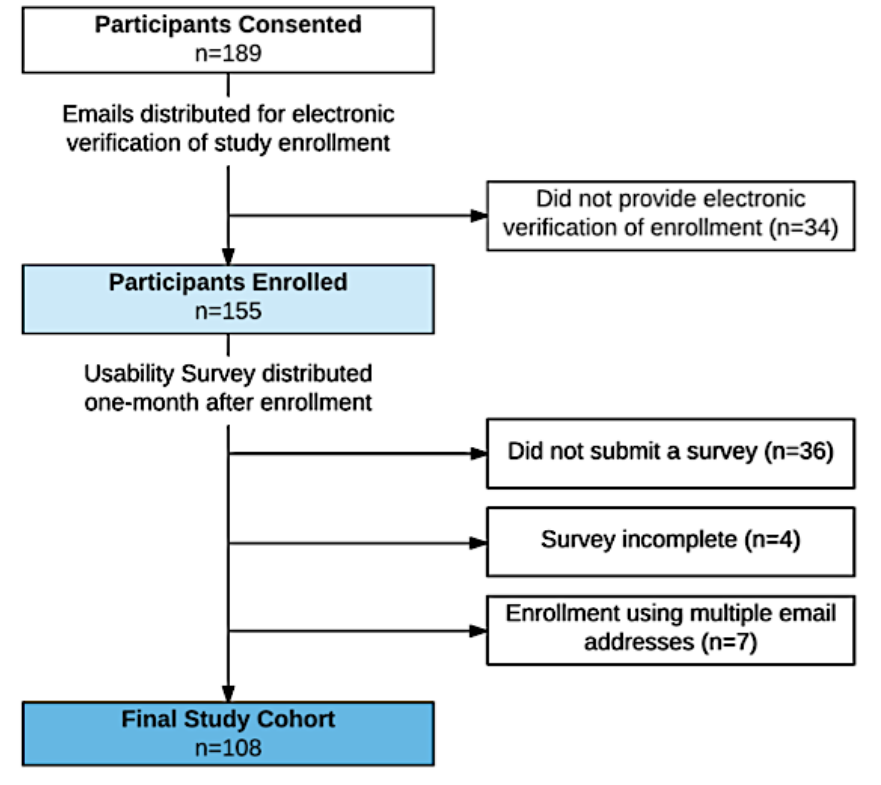
Figure 2. Study flow